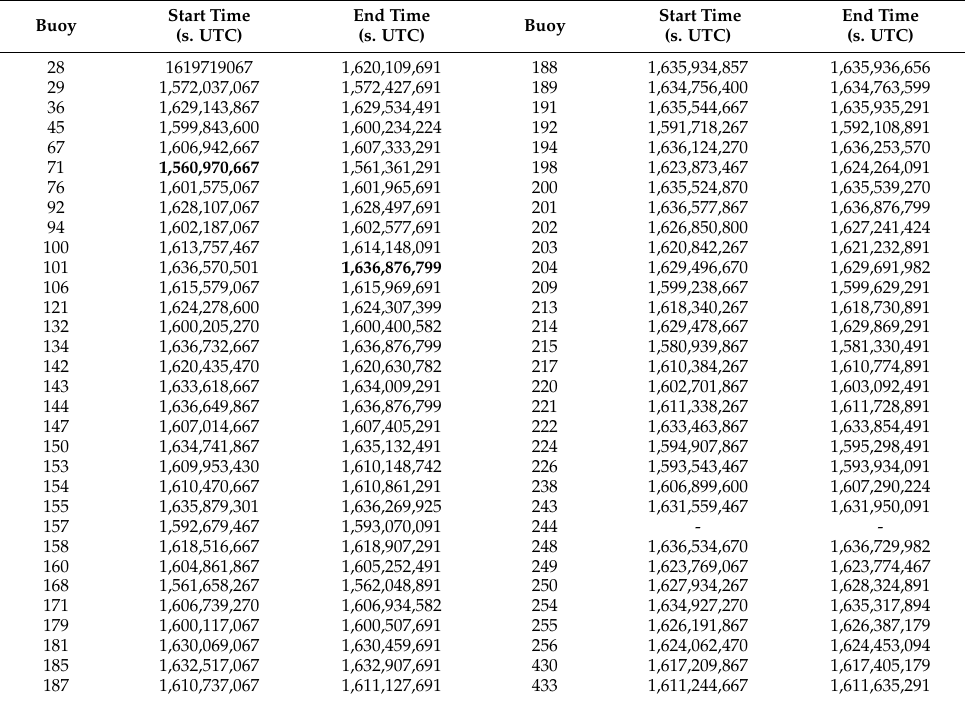
the analysis. In Figure 3, the sea wave heights of 6 buoys that cover the spectrum of mean heights shown in Table 5 are displayed. It is observable from the plots that they correspond to different sea states. In particular, the plot corresponding to buoy 226 (1st row–1st column) represents wave heights that are generally of less than 1 m while the plots corresponding to buoy 433 and 155 (1st row–2nd column and 2nd row–1st column, respectively) show heights that are generally of less than 3 m and that of buoys 222 and 189 (2nd row–2nd column and 3rd row–1st column) have slightly higher values.